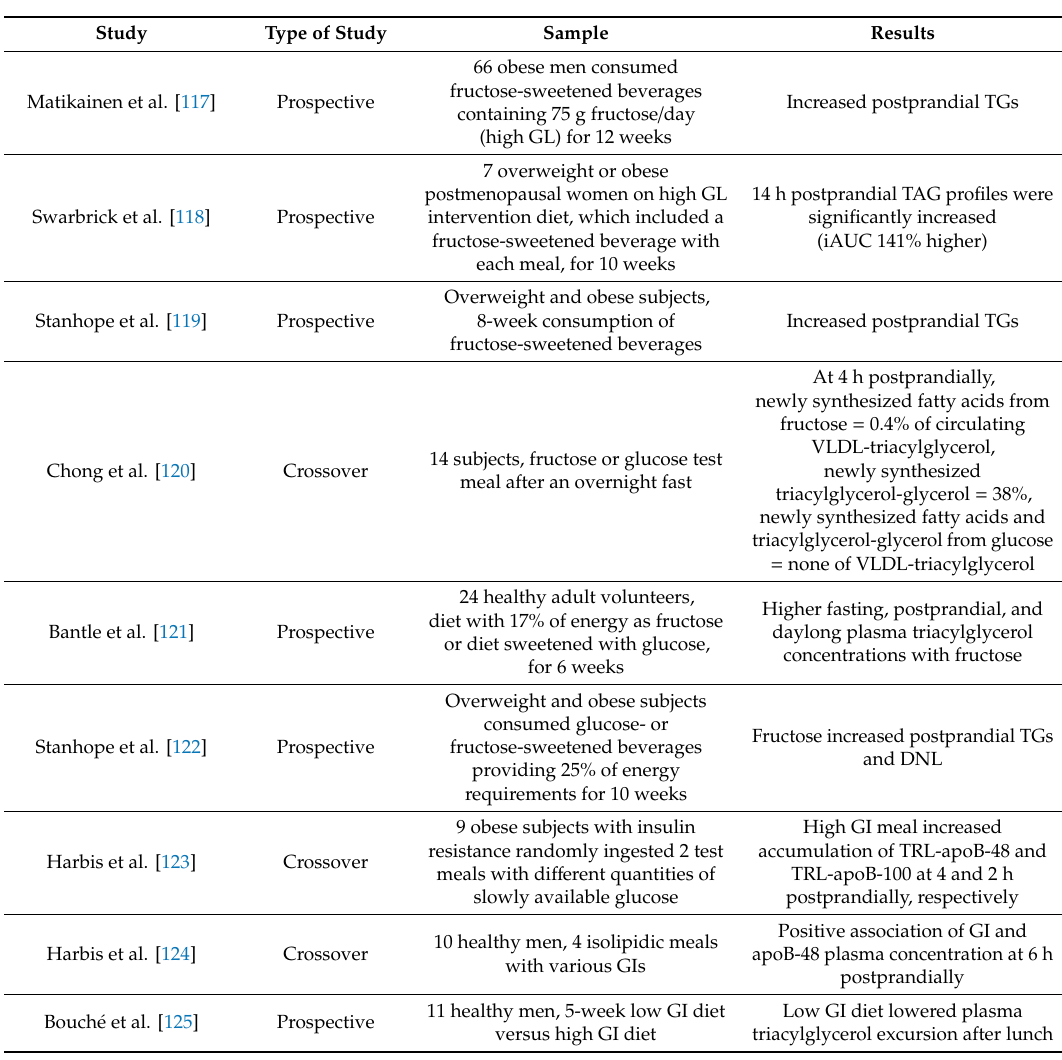
Table 3. Major studies favoring the association of GI and GL with postprandial lipemia. GL, glycemic load; TAG, triacylglycerol; TG, triglycerides; iAUC, incremental area-under-the-curve; VLDL, very low- density lipoprotein; DNL, de novo lipogenesis; TRL, triglyceride lipoproteins; apoB-100, apolipoprotein B-100; apoB-48, apolipoprotein